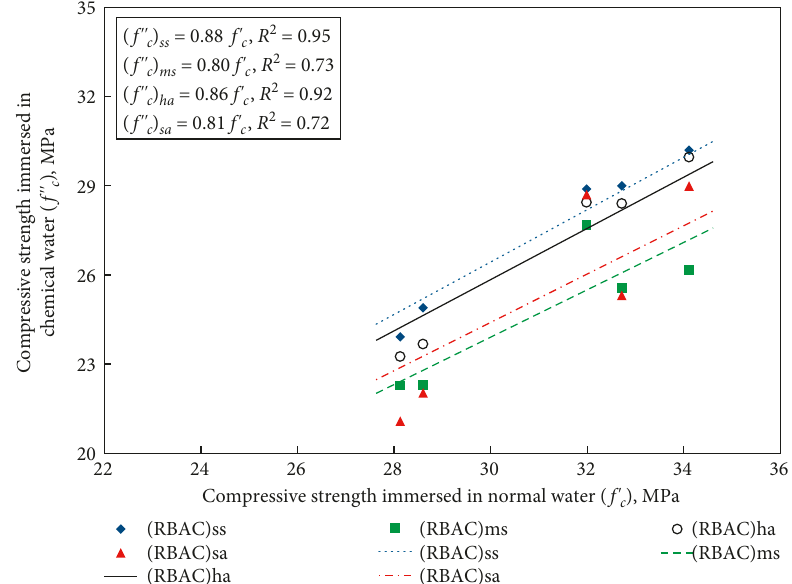
Figure 16: Relationship between the compressive strength of RBAC immersed in normal water and chemical water for 90